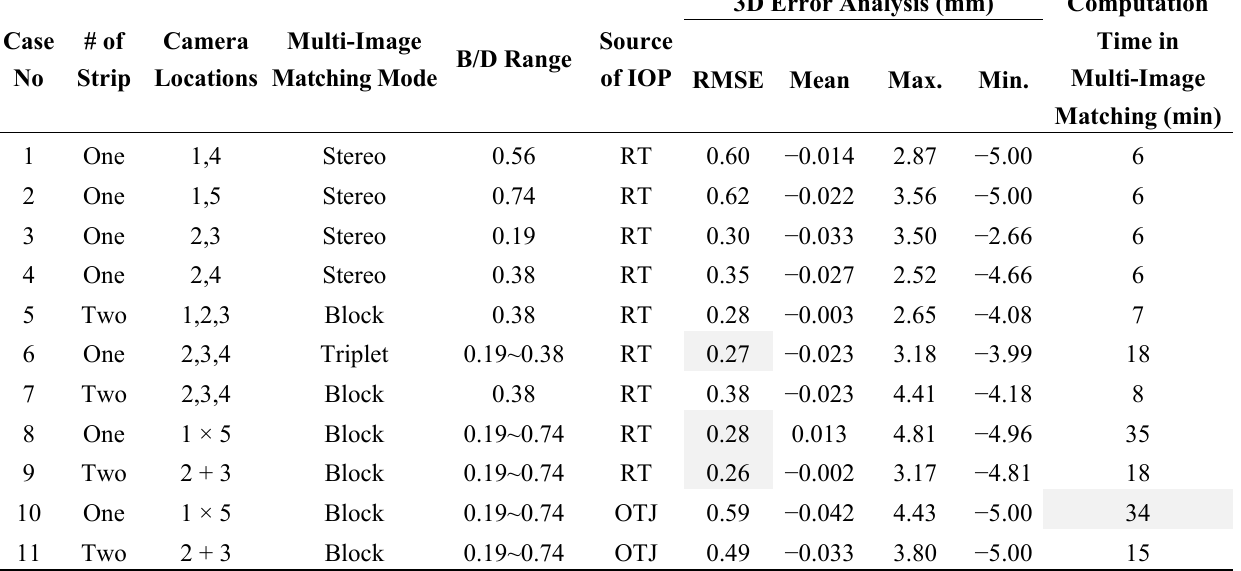
Table 3. Statistics of accuracy analysis for 3D modeling results.